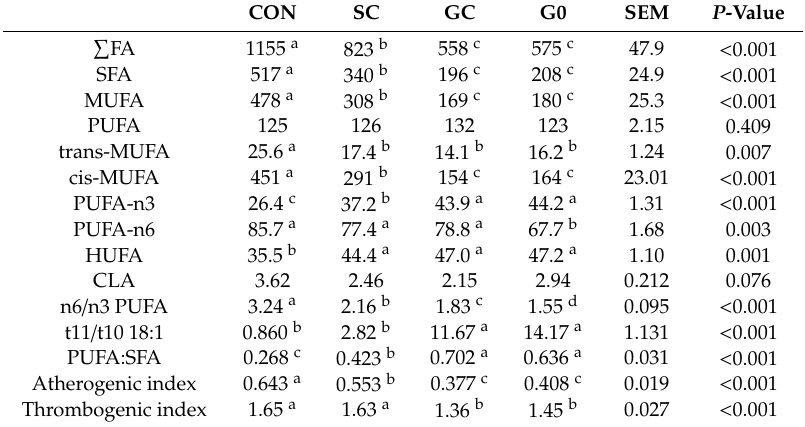
Table 3. Summary of total fatty acids (total FA mg / 100 g muscle), and nutritional ratios of the longissimus thoracis muscle from bulls assigned to one of the following systems: grass silage plus barley-based concentrate ad libitum (CON); grass silage ad libitum plus 5 kg of concentrate (SC); grazed grass without supplementation (G0) or grazed grass plus 0.5 kg of the dietary dry matter intake as concentrate (GC) until slaughter at 15 months. CON SC GC G0 SEM